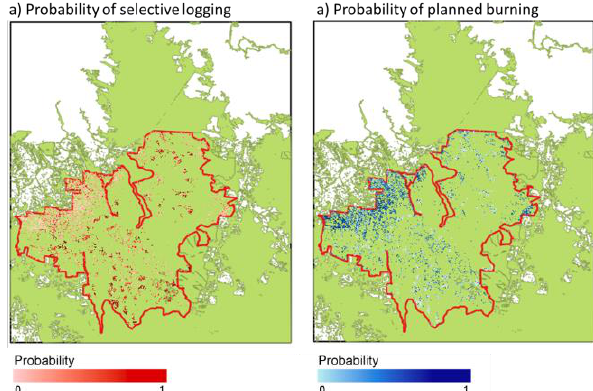
Figure 5: Mapped probability of (a) selective harvesting and (b) low severity wildfire/planned burning.